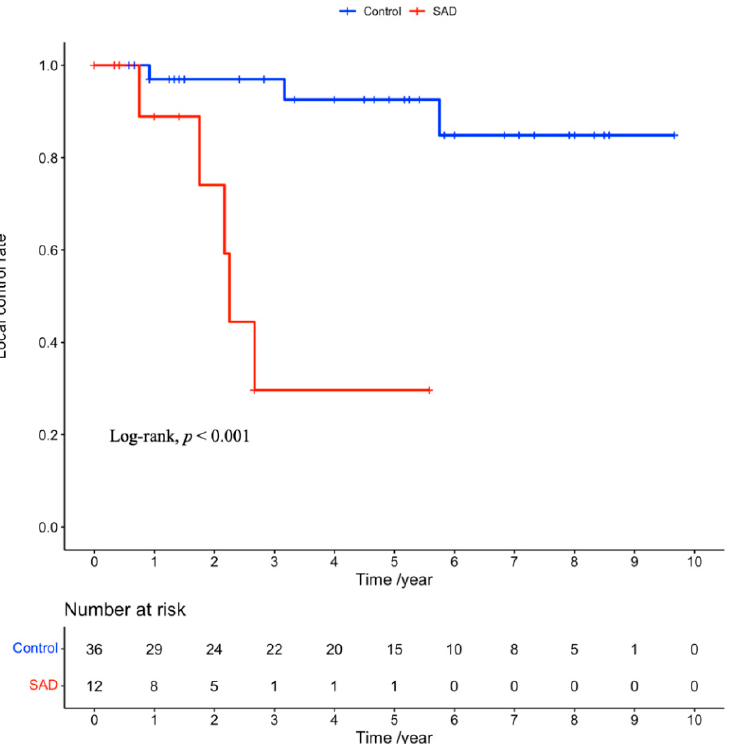
Figure 2. Kaplan–Meier curves for the local control rates in the SAD and control groups. SAD: systemic autoimmune disease.